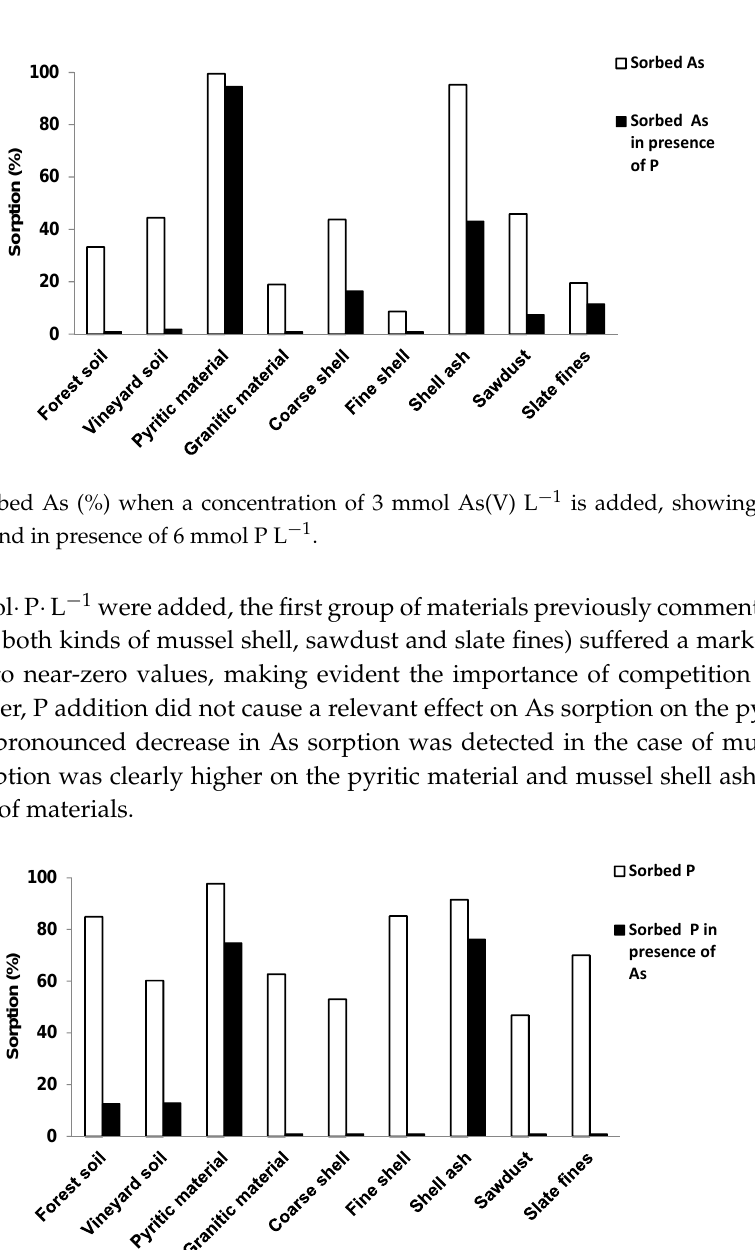
Figure 3. Sorbed P (%) when a concentration of 3 mmol P L − 1 is added, showing results in absence of As and in presence of 6 mmol As L − 1